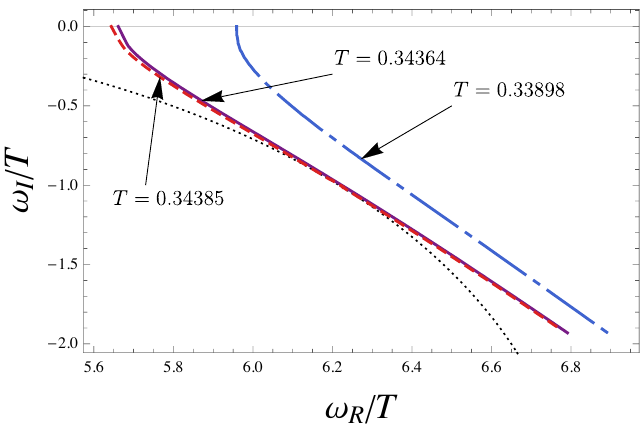
Figure 2 . Trajectories of the poles at fixed temperatures when we vary E and J along the corre- sponding J - E curve in figure 1. The dotted line is a reference line at E = 0 for various temperatures.